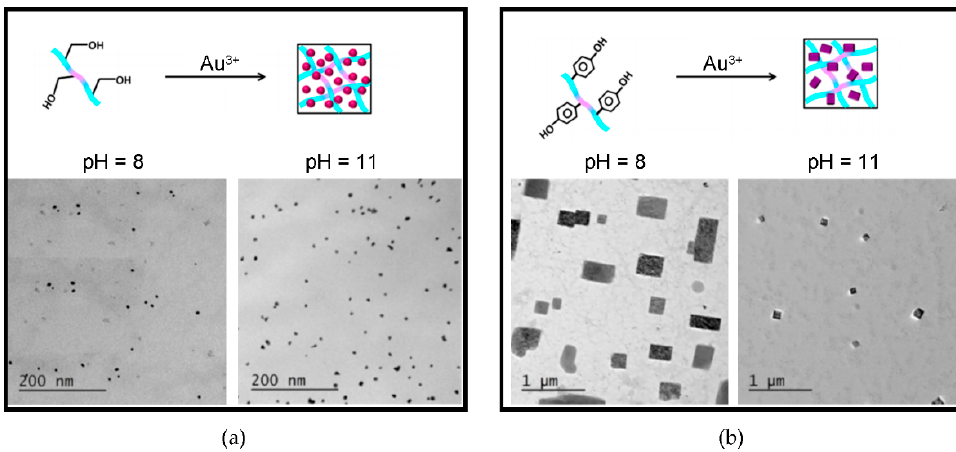
Figure 3. Self-assembling Fmoc-dipeptides template gold NPs with control over shape and size. ( a ) Fmoc-Phe-Ser yields spherical NPs. ( b ) Fmoc-Phe-Tyr yields rectangular plates. Adapted with permission from [65]. Copyright © 2021, American Chemical Society.